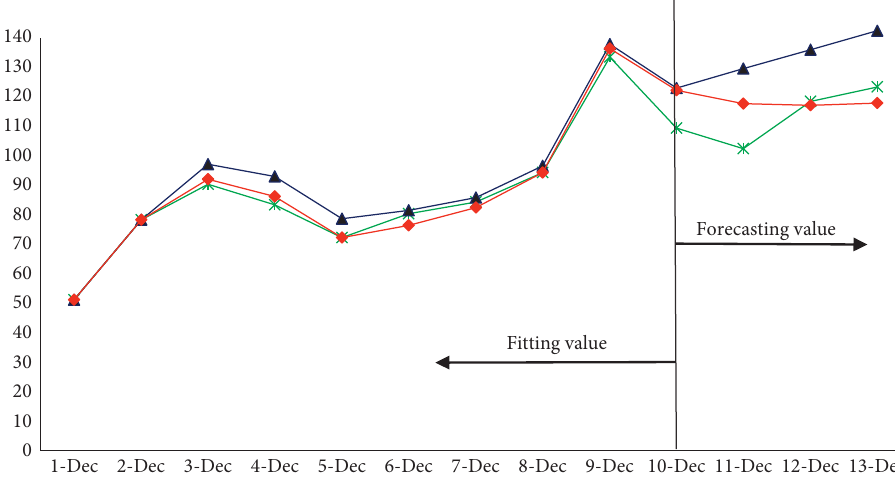
Figure 1: Comparison of AAES and ES forecasting